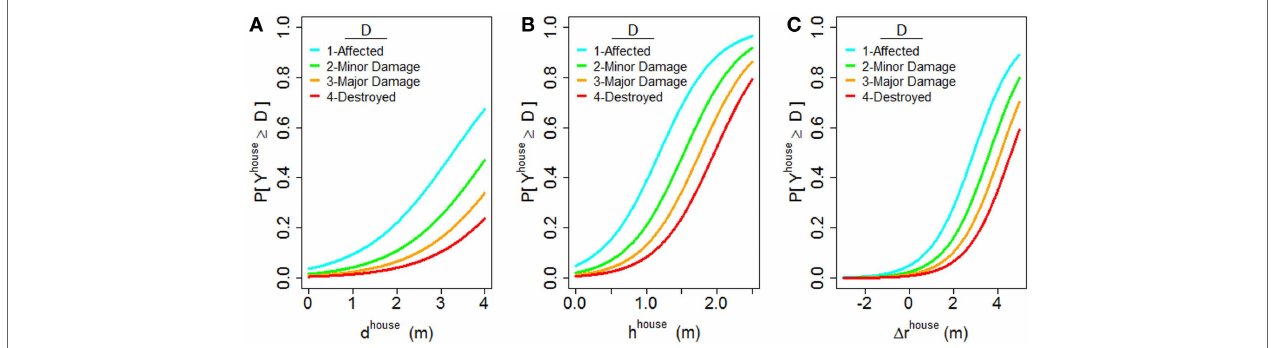
FIGURE 8 | Fragility curves relating probability of exceeding a damage state to (A) maximum inundation, (B) significant wave height, and (C) relative inundation.